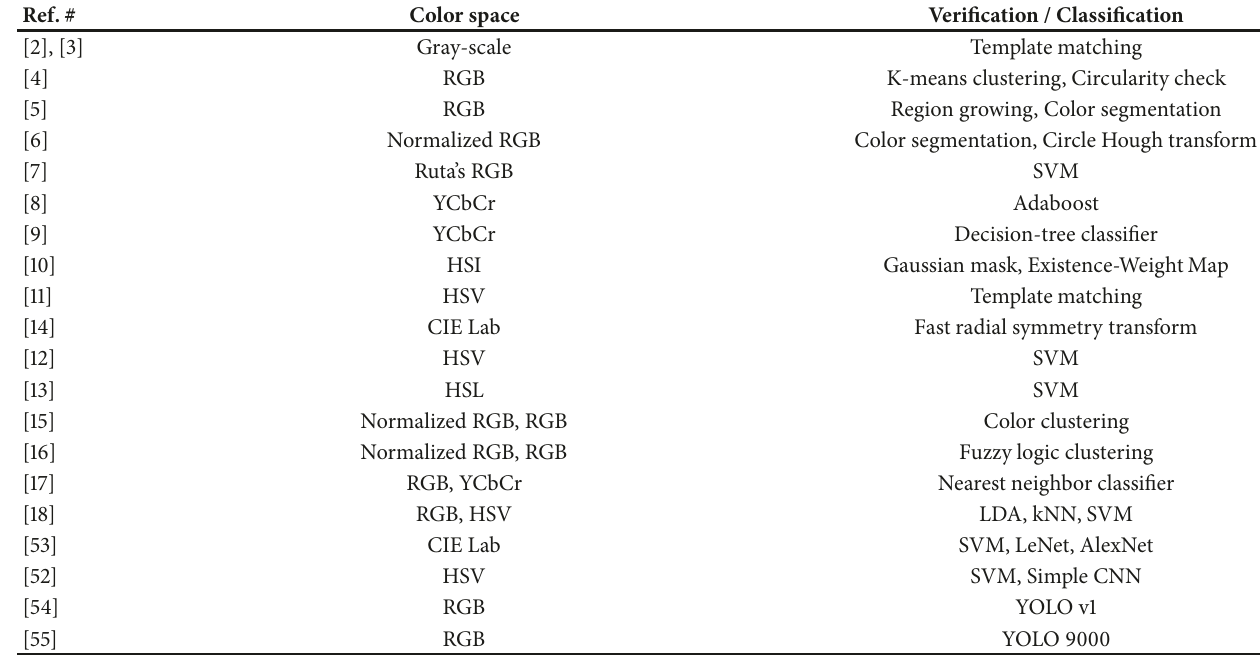
Table 1: Color space and verification/classification used in previous traffic light detection. Ref.